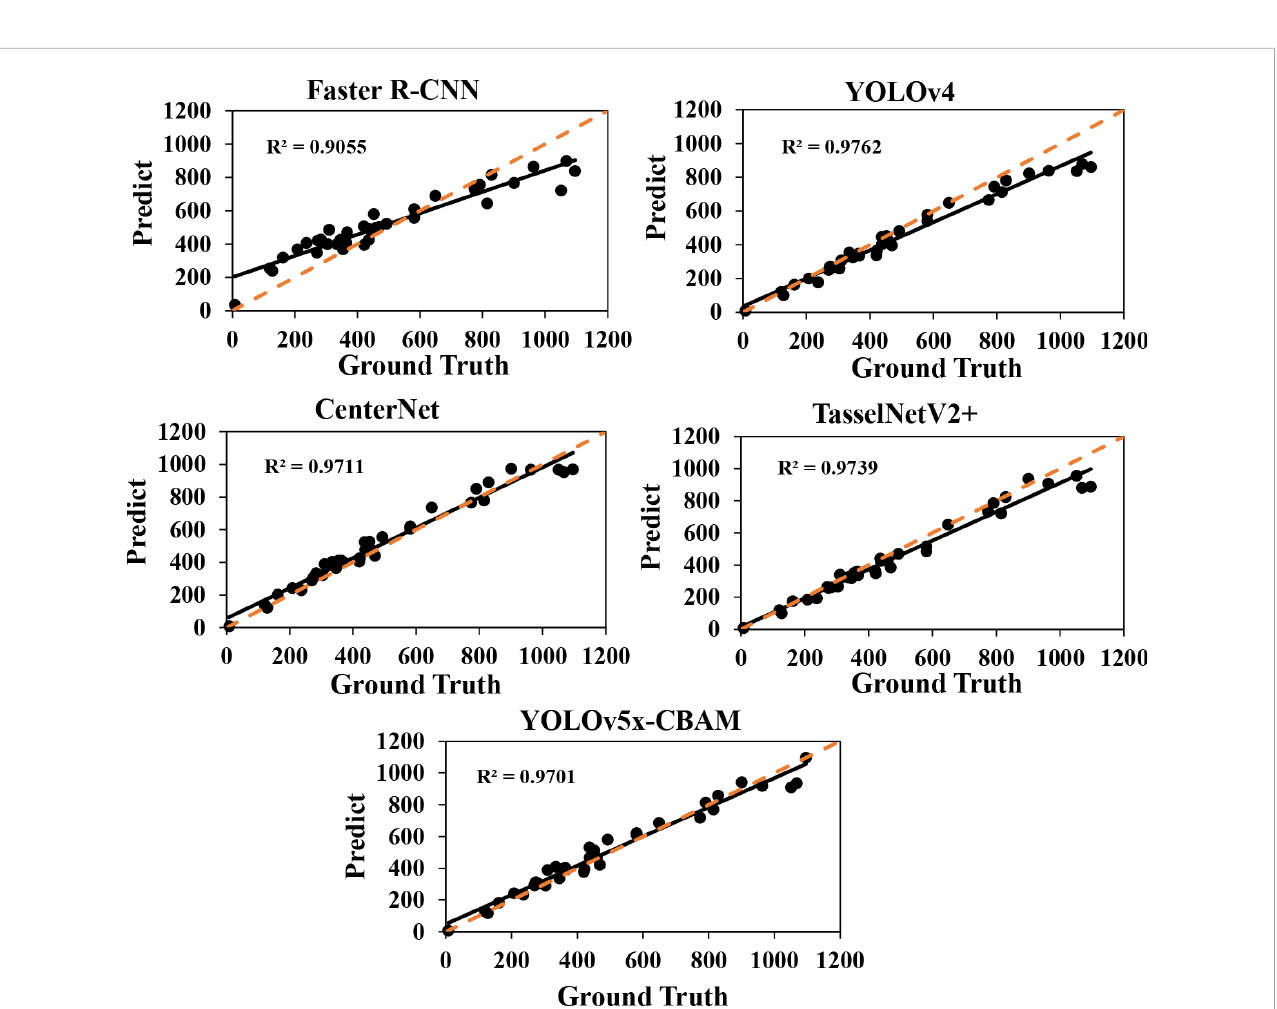
FIGURE 5 Fitting curves of predicted and true values of fi ve network models. The R 2 value represents the fi tting effect. The orange dotted line represents the 1: 1 fi tted